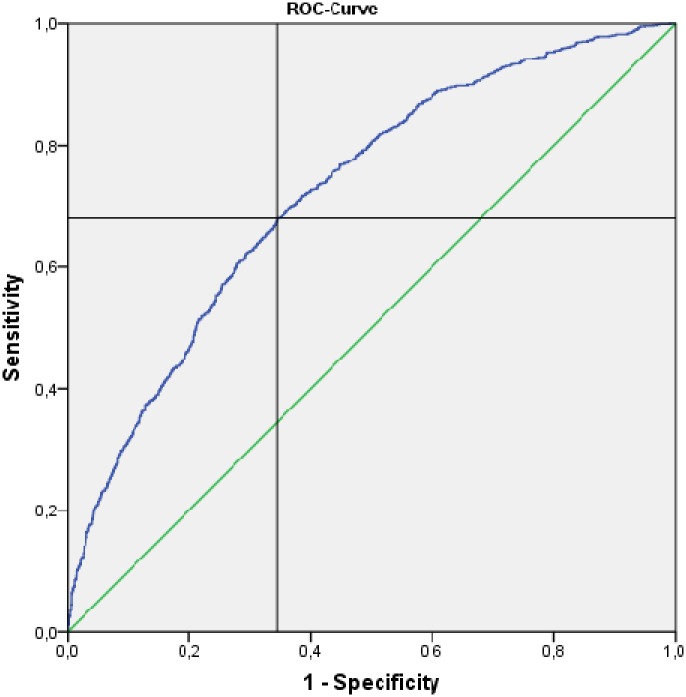
ROC curve of the final multivariable regression model.AUC (95% CI) 0.723 (0.704, 0.742). Optimal cut-off score > 0.3714649.